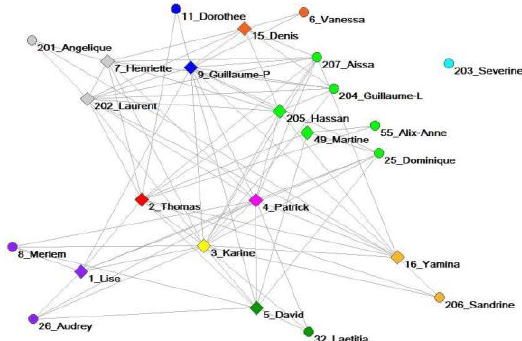
Fig.17. Florence's network in 2004, with